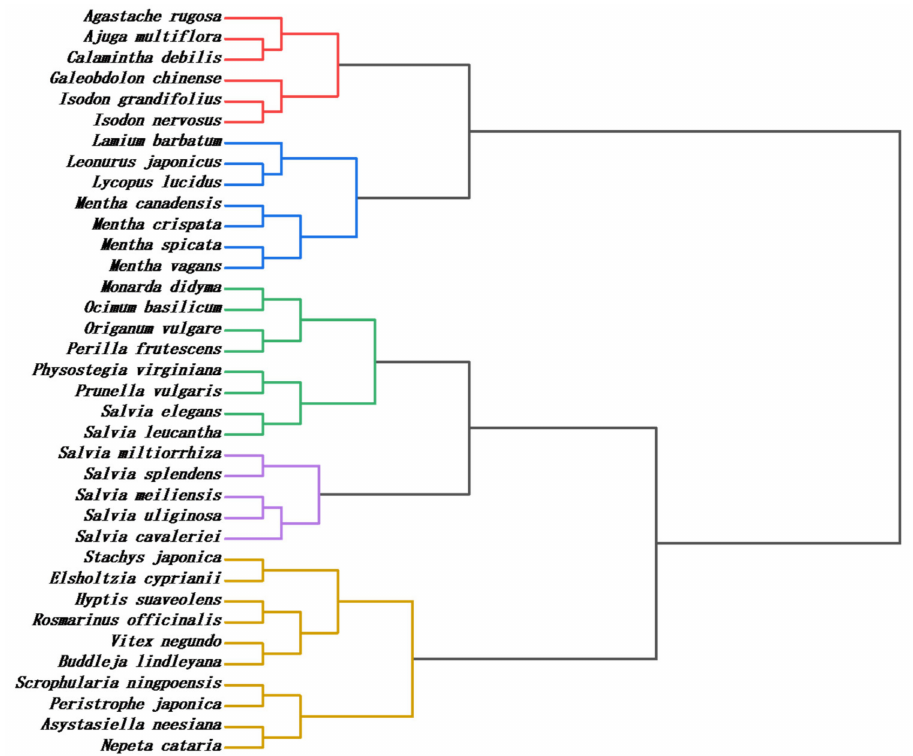
Figure 7. Dendrogram of 31 species from 22 genera in the family Lamiaceae and 5 exotaxa based on electrochemical